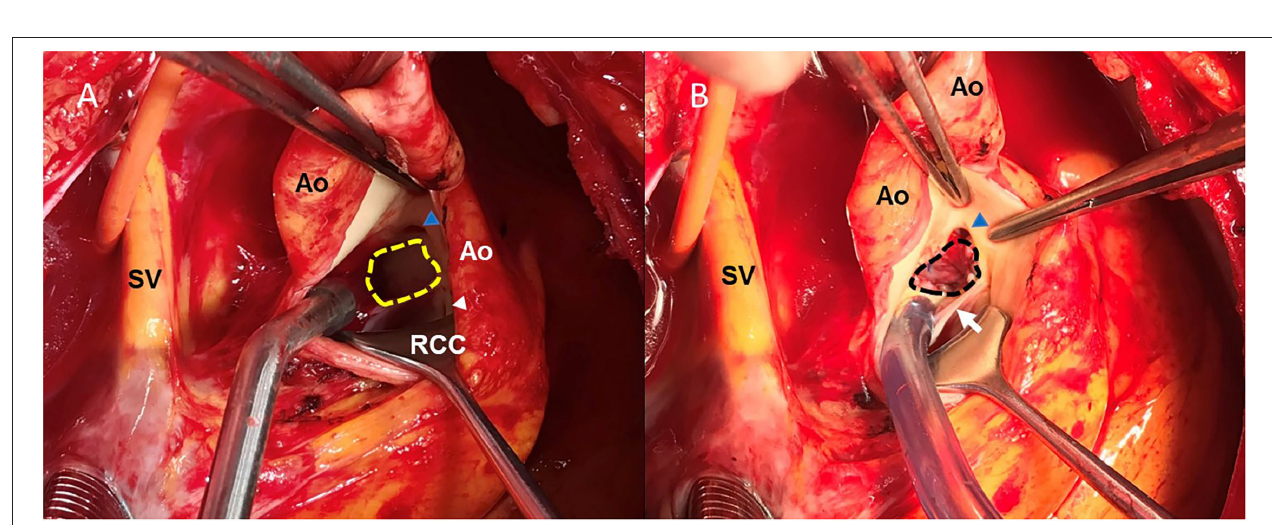
FIGURE 4 | The gross view of the aneurysm in situ initially observed before (A) and after (B) the surgical exclusion. The neck of the aneurysm originated from the left sinus of Valsalva (shown in the yellow-dotted border), and the LMCA originated from the LCC, just above the neck of the aneurysm (A) . A patch (shown in black-dotted border) was used to close the opening of the aneurysm, thereby, reconstructing the left coronary sinus (B) . LMCA, left main coronary artery; Ao, aorta; SV, superior vena cava; LCC, left coronary cusp; RCC, right coronary cusp; blue triangle, the opening of the LCMA; white triangle, the opening of the right coronary artery; white arrow, left and right coronary